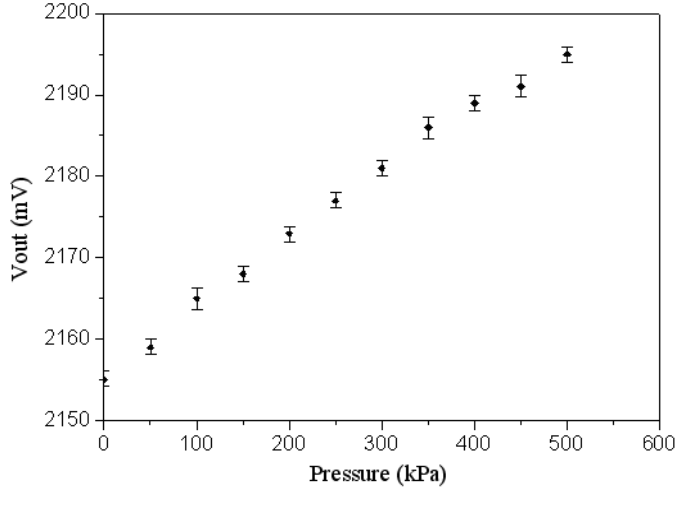
Figure 13. Output power of the pressure